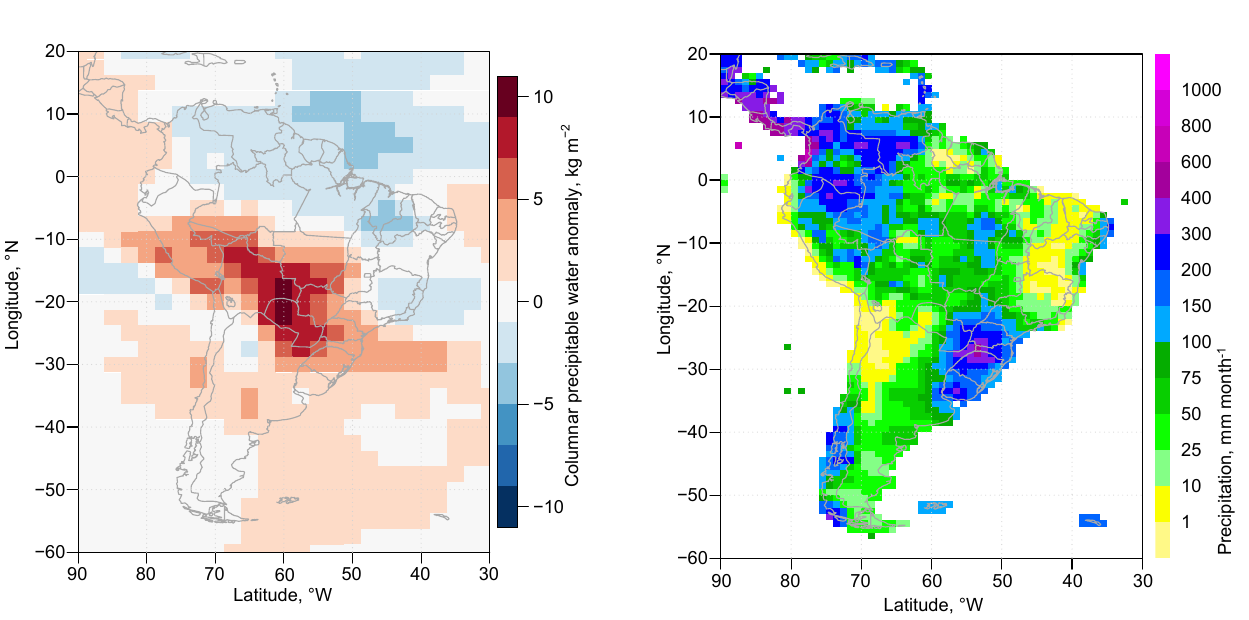
Figure 3. Total rainfall (millimeters per month, 1 ◦ resolution) for September 2014. Data are from the Global Precipitation Climatol- ogy Centre